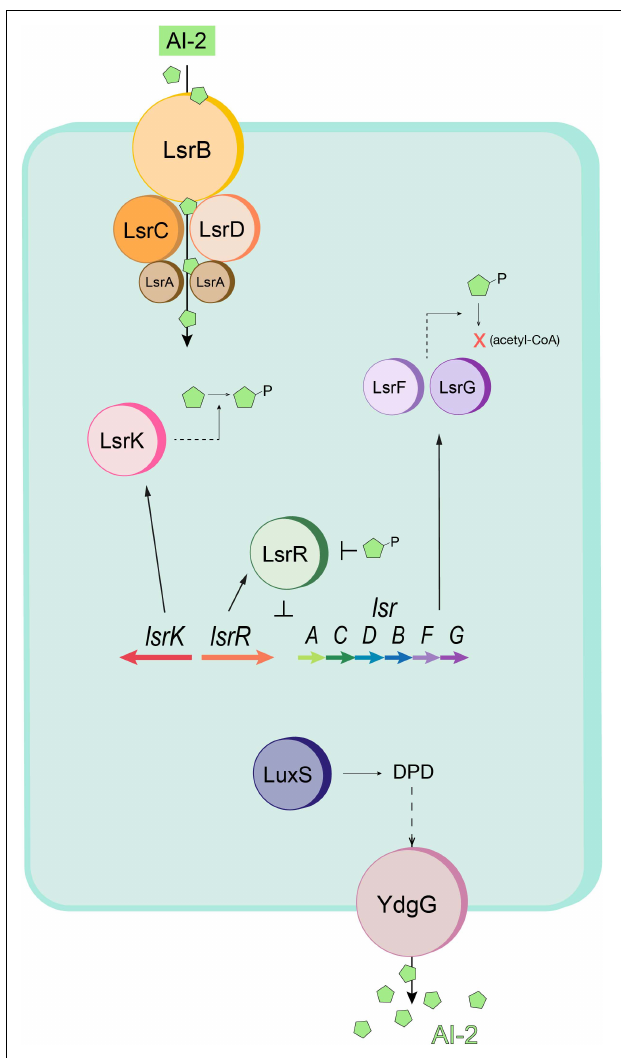
FIGURE 1 | Schematic of the E. coli quorum sensing (Lsr) system. AI-2 (green pentagons) is imported into the cell by the Lsr transporter (LsrACDB) and is then phosphorylated to AI-2P by LsrK. When AI-2P binds LsrR and releases LsrR from the promoter region (thus modulating Lsr gene expression), AI-2 uptake is increased. Intracellular AI-2P is processed and degraded by LsrF and LsrG. LuxS produces DPD, the precursor to AI-2. The autoinducer is exported by YdgG (TqsA). Adapted from Wang S. et al.